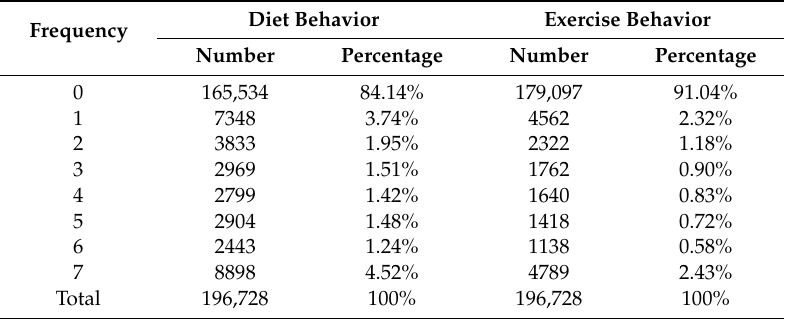
Table 1. Health behaviors recorded